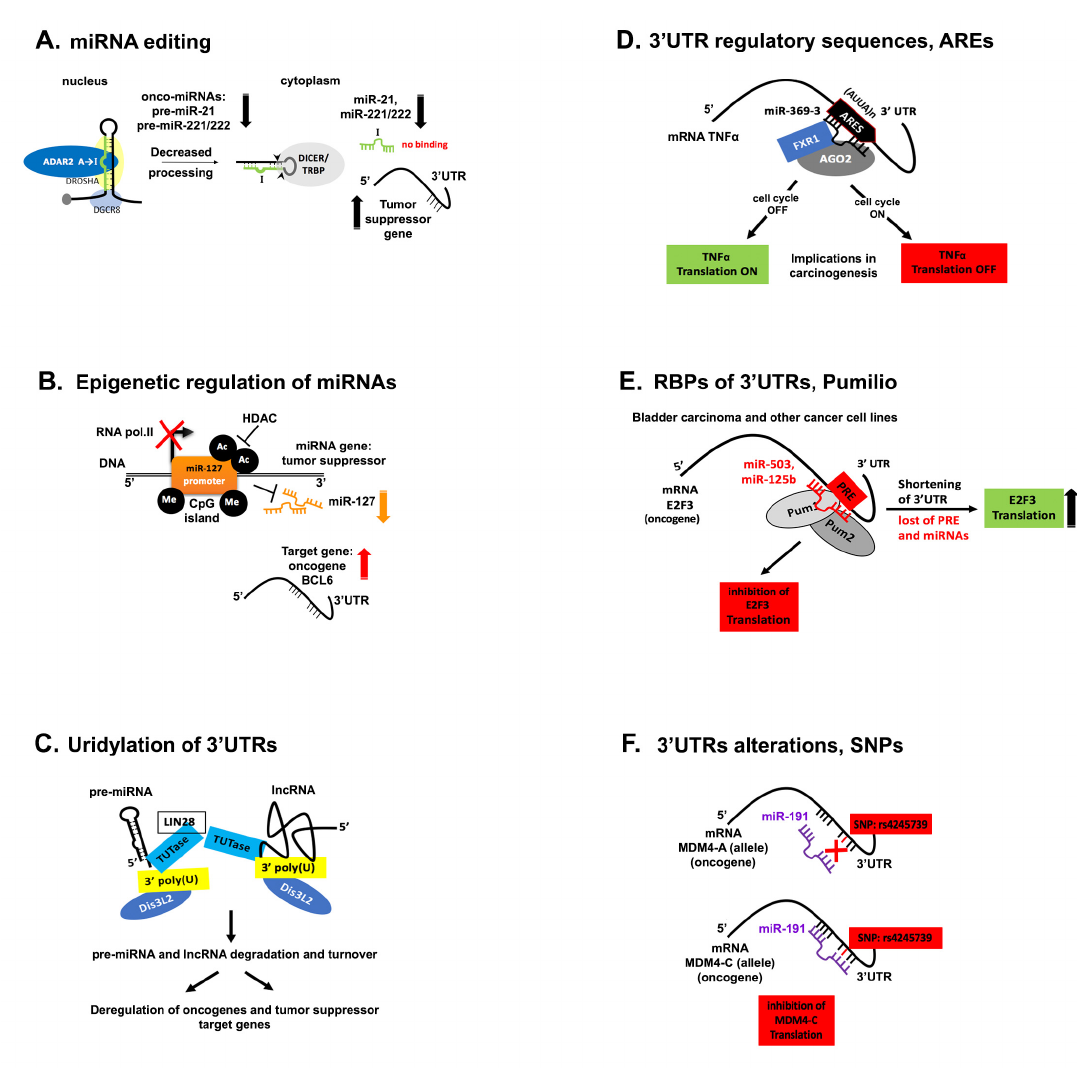
Figure 3. Disruption of ncRNA Networks in Cancer. ( A ): miRNA editing: in glioblastoma, ADAR2